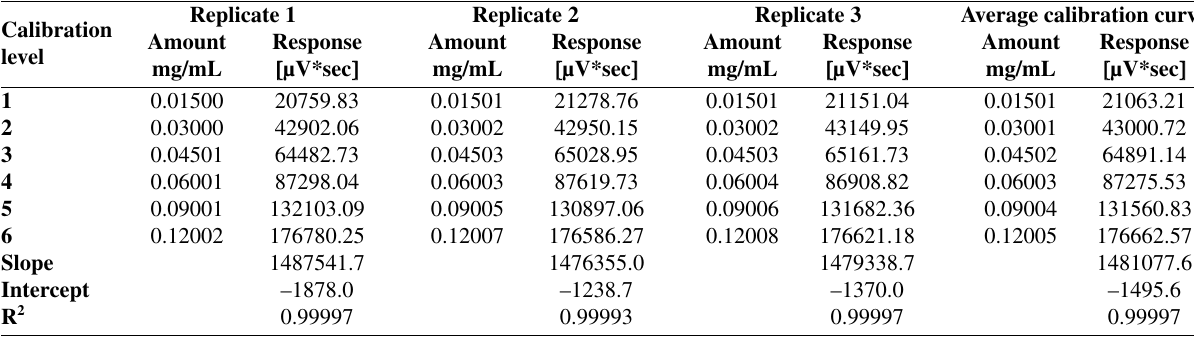
Table 7. Calibration curve data for BKC by optimized HPLC method in concentration range 15–120 μg/mL.